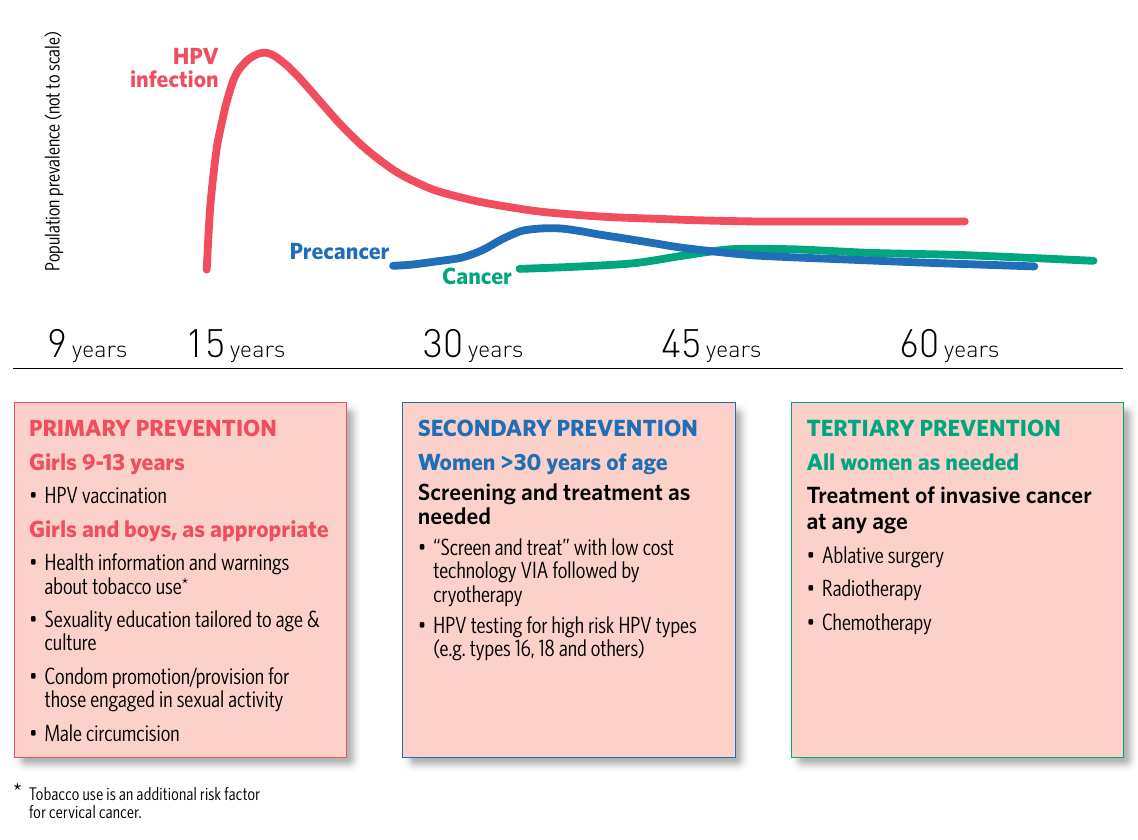
FIGURE 1: OVERVIEW OF PROGRAMMATIC INTERVENTIONS OVER THE LIFE COURSE TO PREVENT HPV INFECTION AND CERVICAL